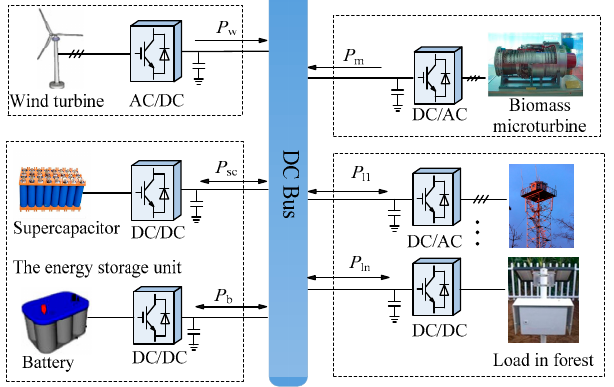
Figure 1. System structure of DC microgrid with wind turbine, energy storage, and biomass energy.